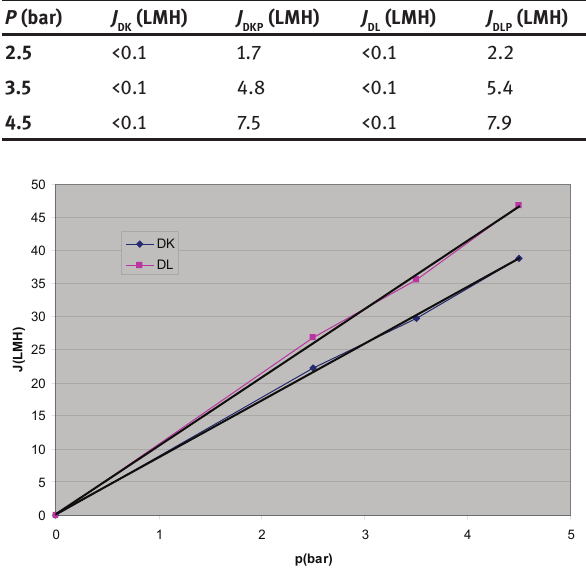
Figure 4: Millipore water flux as a function of pressure.